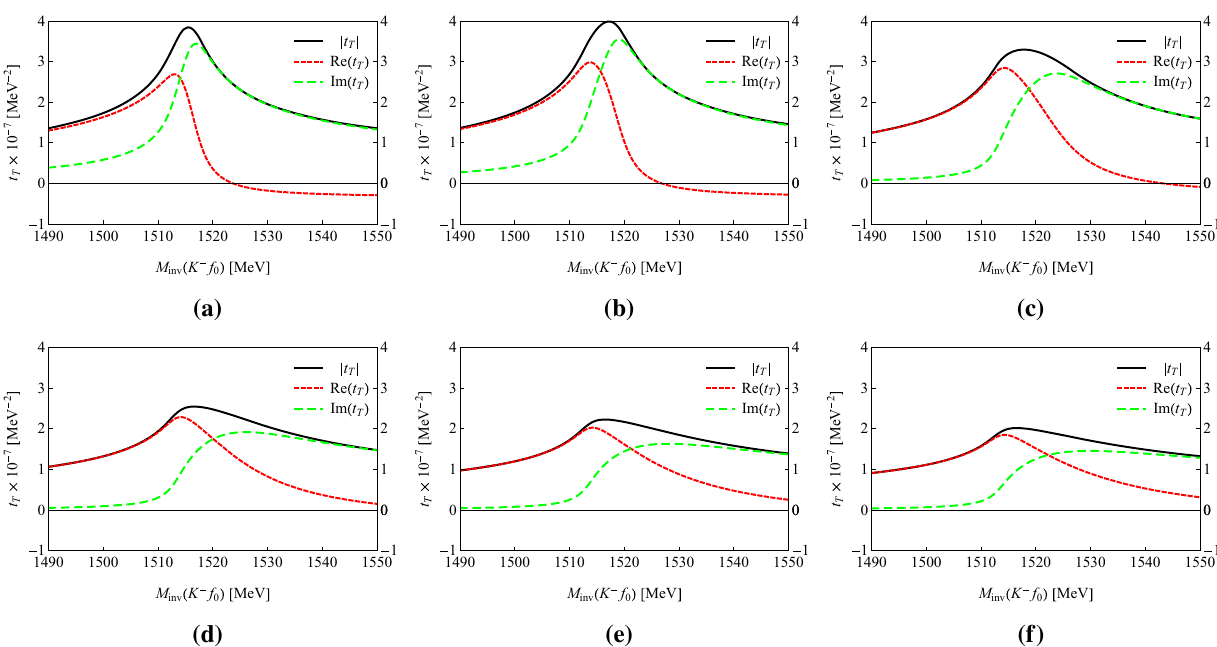
= 981 MeV. | t and f m f 0 ( a 0 ) the black, red, and green curves,